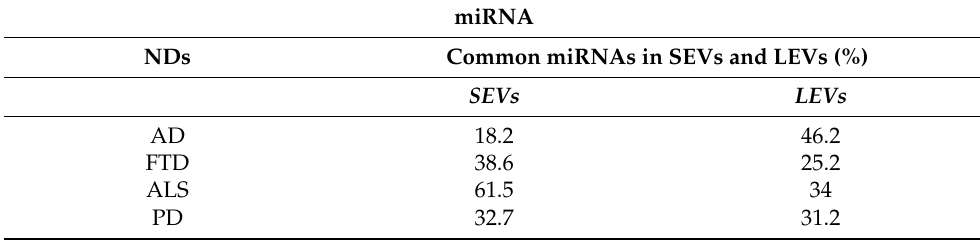
ND = Neurodegenerative Disease; AD = Alzheimer Disease; FTD = Fronto-Temporal Dementia; ALS = Amyotrophic Lateral Sclerosis; PD = Parkinson Disease; CTRs = controls; SEVs = small extracellular vesicles; LEVs = large extracellular vesicles; miRNAs = micro